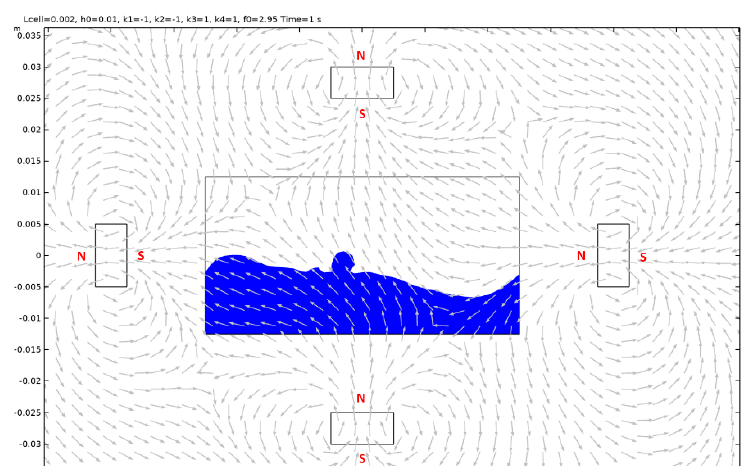
Figure A19. Case 5.